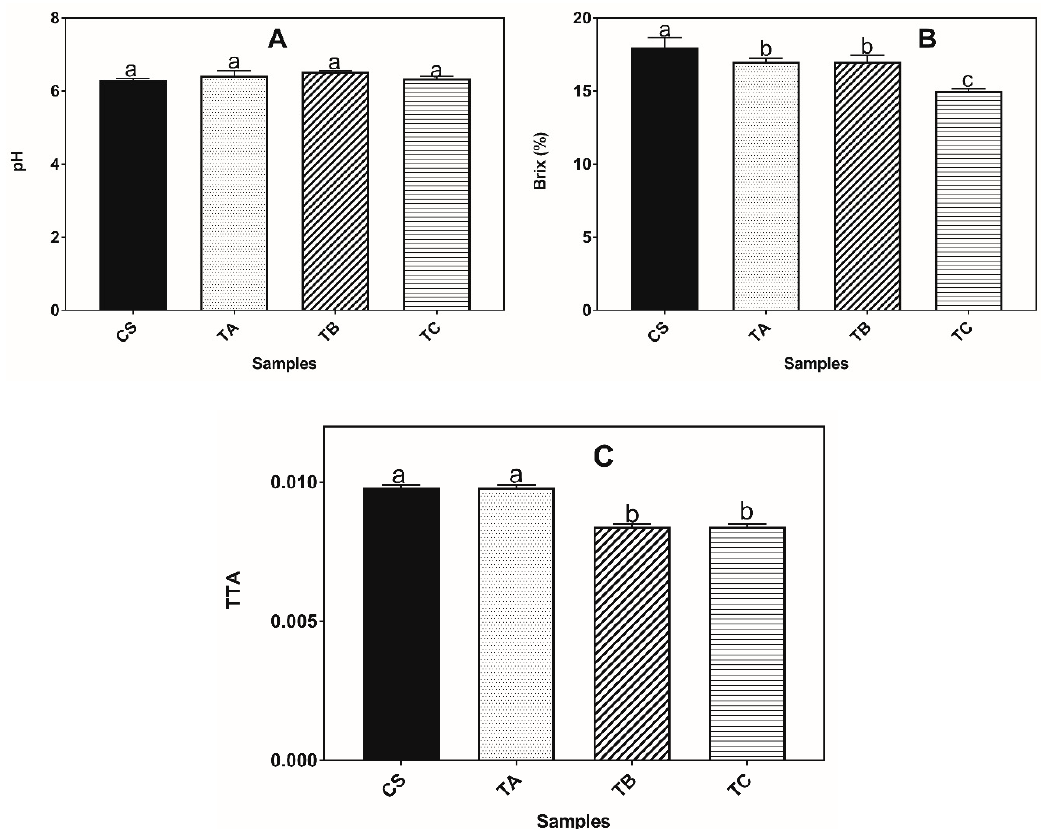
Figure 3. pH ( A ), Brix ( B ) and total titratable acid (TTA) ( C ) values (mean ± standard deviation, n = 3) of the smoothies. Bars with different letters indicate values that are significantly different ( p < 0.05). CS: 45% Pineapple, 40% Banana, 15% Apple; TA: 44.5% Pineapple, 39.5% Banana, 14.5% Apple, 1.5% Moringa leaves; TB: 44% Pineapple, 39% Banana, 14% Apple, 3% Moringa leaves; TC: 43.5% Pineapple, 38.5% Banana, 13.5% Apple, 4.5% Moringa leaves.